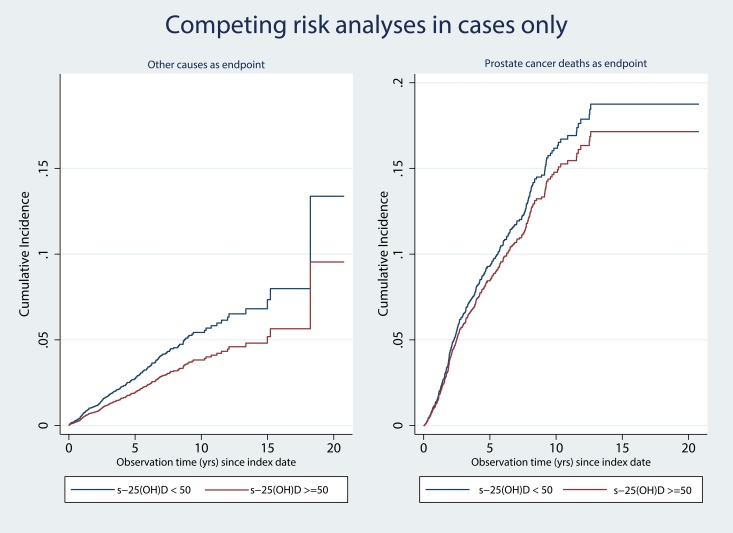
Cumulative mortality from other causes than prostate cancer (A) and cumulative mortality from prostate cancer (B), in men with a prostate cancer diagnosis (n = 2259) according to strata of 25(OH)D concentration. Adjusted for age, month of blood sampling, examination, physical activity, BMI, smoking and education. Death from prostate cancer (n = 381) and death from all other causes (n = 228) was set as competing events in panel A and B, respectively.